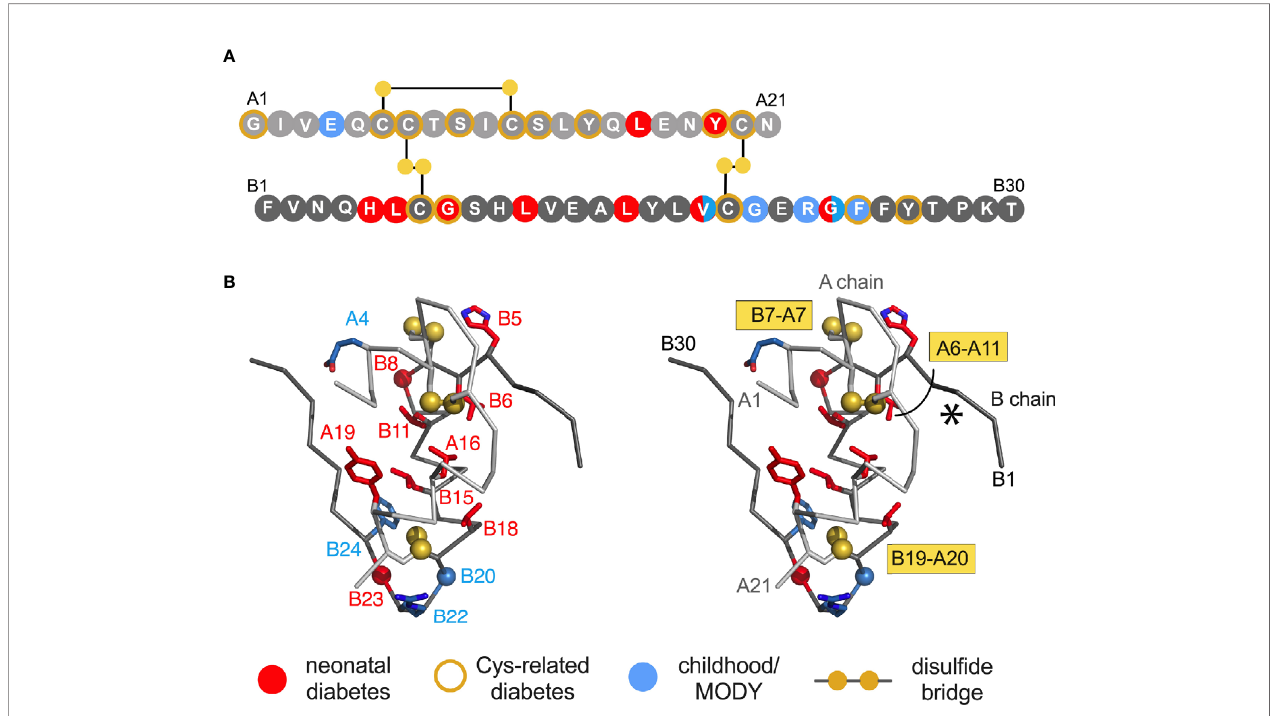
FIGURE 1 | Clinical mutations in INS gene. (A) Sequence of insulin showing positions of clinical mutations. Residues are labelled by standard single letter code (bold white). The A chain is shown as light gray circles (upper sequence), and B chain as dark gray circles (lower sequence). Color code: neonatal- or delayed onset is indicated by fi lled red or blue circles, respectively. Sites of Cys-related mutations are highlighted by gold borders ( Tables 1A, B ). Disul fi de bridges are indicated by fi lled gold circles connected by black lines. (B) Stereo view of insulin monomer (C a -trace ribbon model; PDB entry 4INS) (47). Non-Cys-related mutations are highlighted as in (A) ; side chains are shown in red as labeled ( Tables 1C, D ). The C a atoms of Gly B8 , Gly B20 and Gly B23 are respectively shown as red, blue and red spheres (one-third Van der Waals radii), and sulfur atoms likewise as gold spheres. The A- and B chain ribbons are shown in light and dark gray, respectively. For clarity, symbols are also de fi ned at